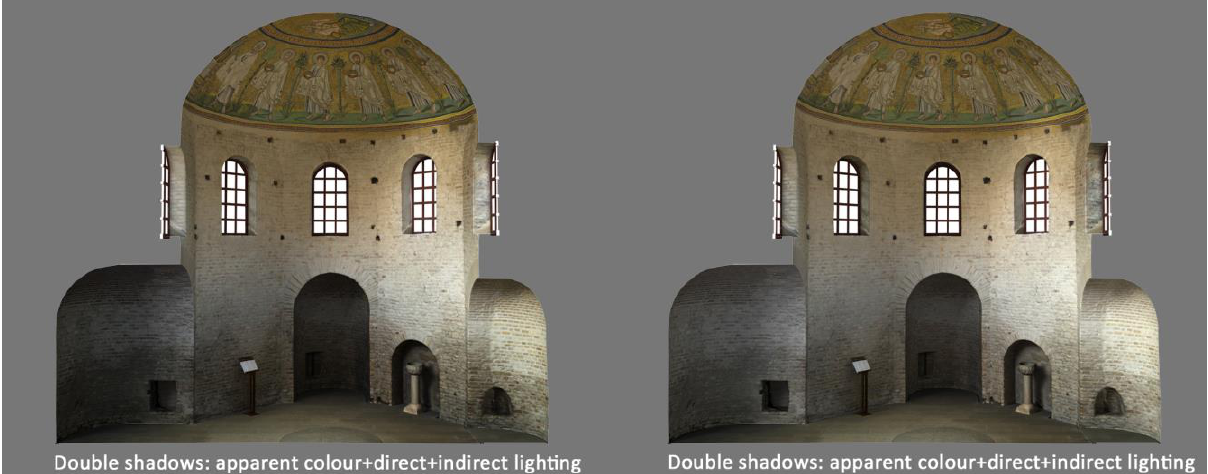
Figure 11. Test renders of Arian